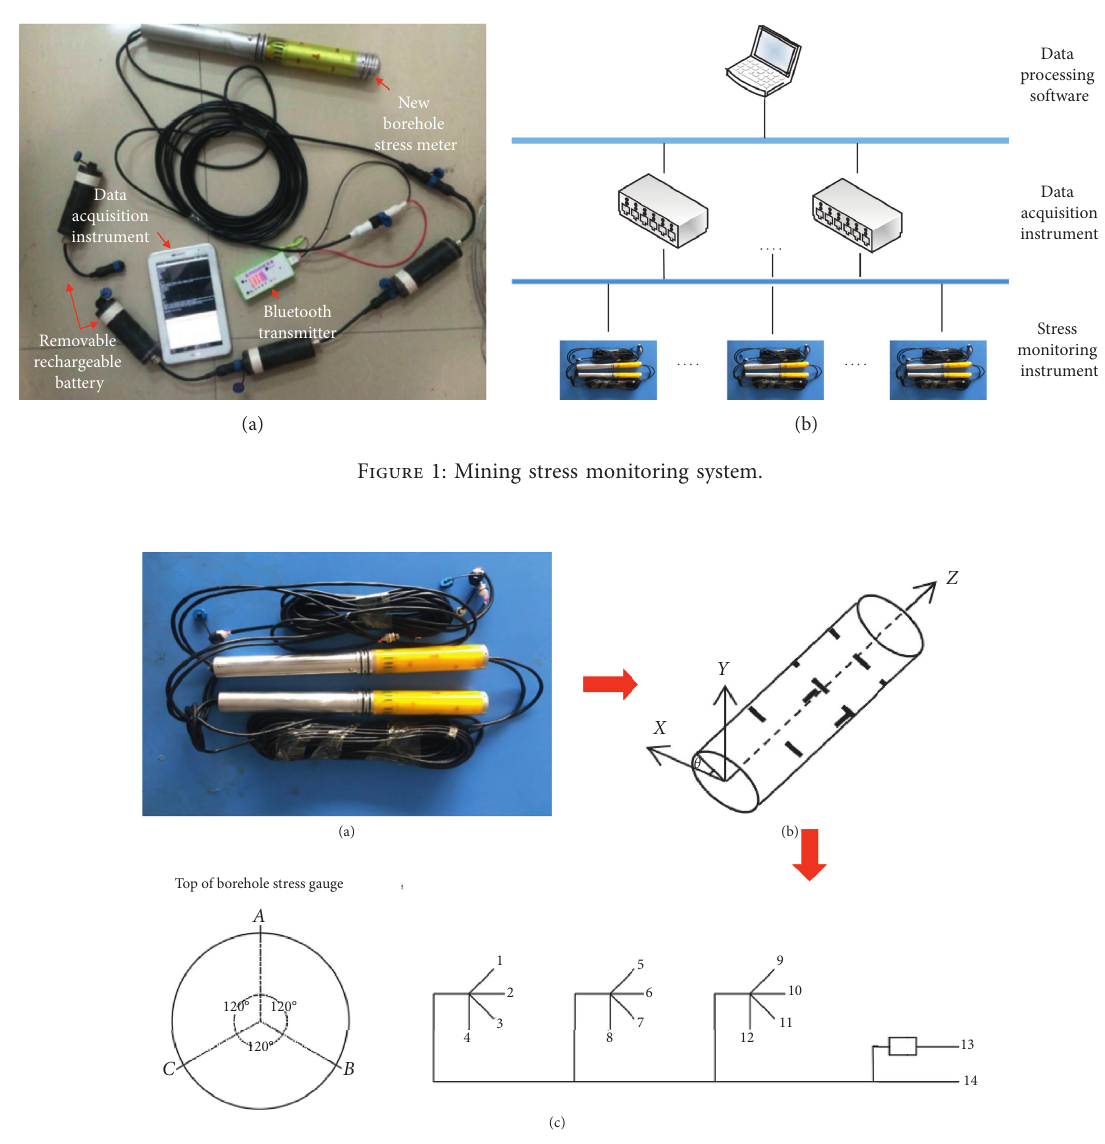
Figure 2: Monitoring probe strain gauge layout plan: (a), (b), and (c) three groups of strain gauges.